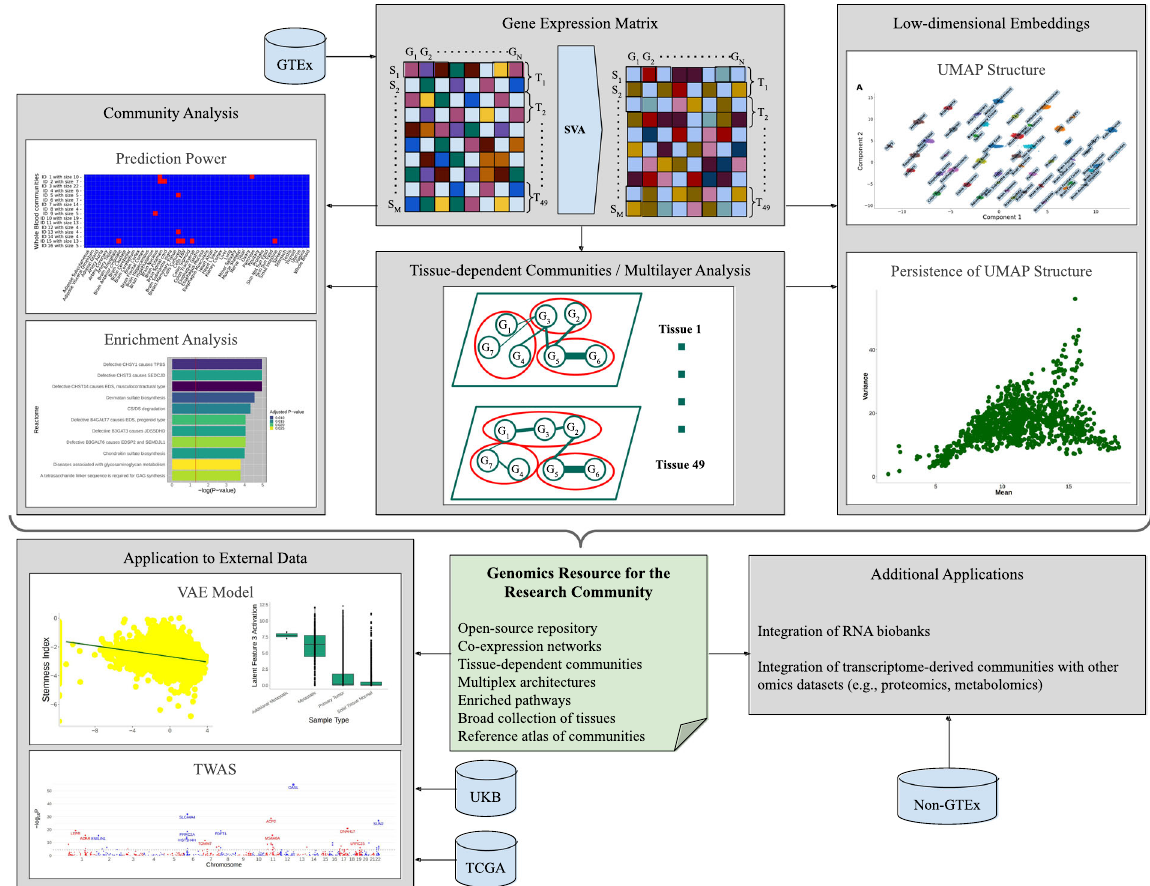
Fig. 1 Study design. We leverage the matrix of gene expression in 49 GTEx tissues. Surrogate variable analysis (SVA) is applied to the high- dimensional dataset to adjust for unknown or unmodelled confounders. Tissue-dependent communities are generated, analysed, tested for enrichment for known biological processes, and exploited towards identi fi cation of new functional gene sets. Uniform Manifold Approximation and Projection (UMAP) embeddings of gene expression data de fi ned by the communities, and the persistence of the global structure, are evaluated to identify biologically-meaningful clusters. Notably, new datasets can be embedded into the derived models to facilitate additional discoveries. Potential external applications of the resource of gene expression communities are varied. Here, we implement two community-based applications, including a deep learning (variational autoencoder) model and transcriptome-wide association studies (TWAS) using the TCGA and the UK Biobank datasets,